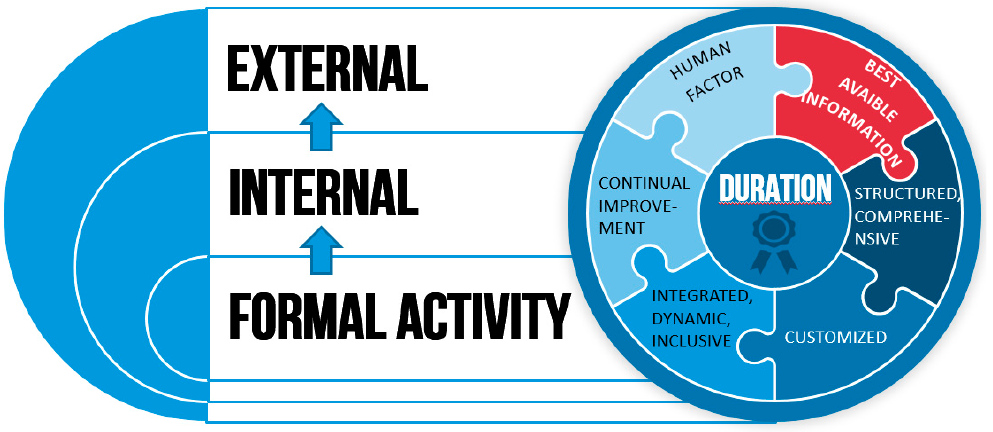
Figure 1. The elements for the project value creation.